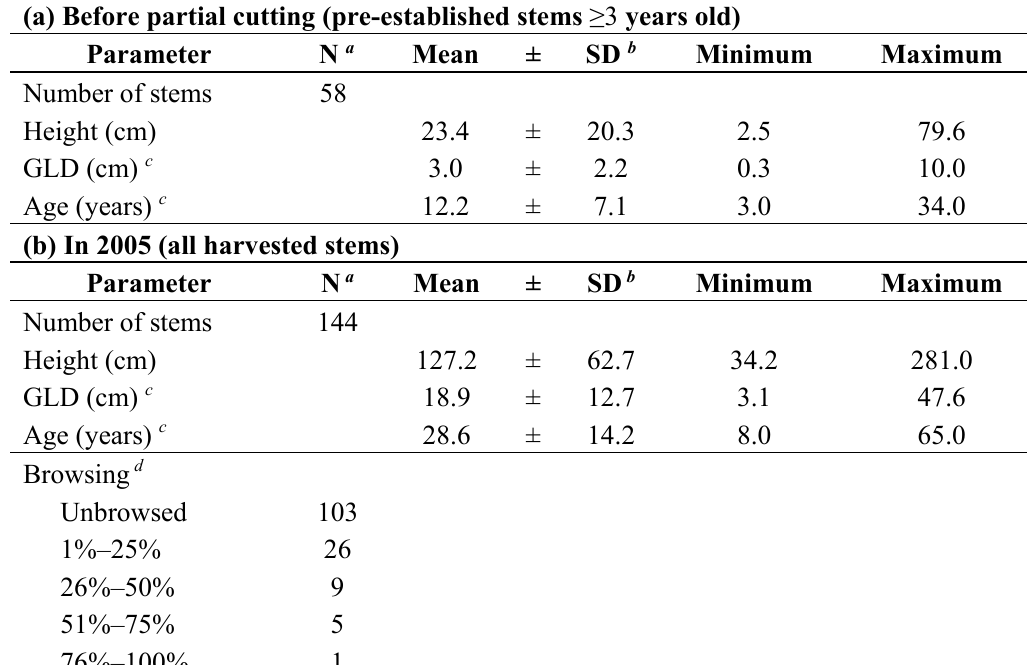
Table 3. Descriptive characteristics of northern white-cedar harvested stems on the Outaouais Region (OR site) and Papineau-Labelle wildlife reserve (PL site) ( a ) just before the last partial cutting that occurred between 1971 and 1983; and ( b ) in 2005, when they were harvested during the current